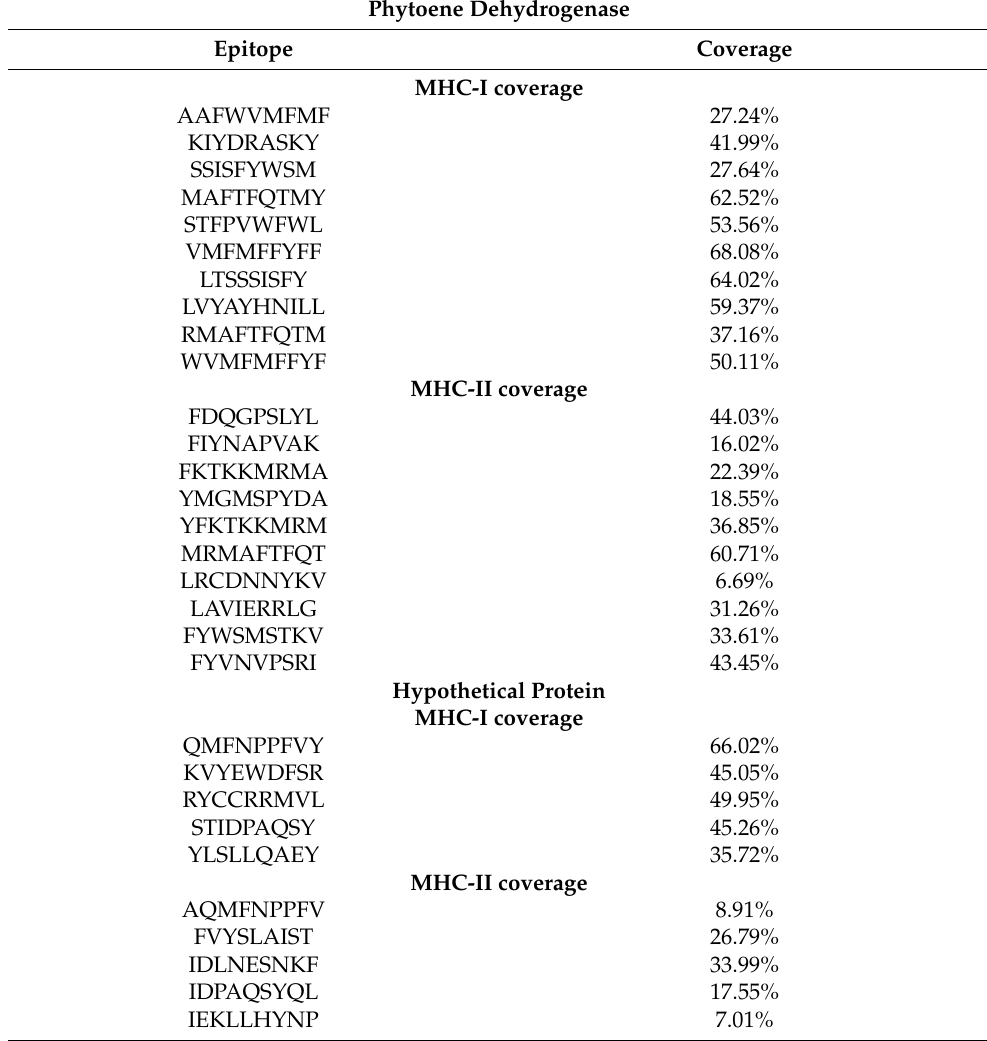
Table 3. World population coverage of MHC-I and MHC-II epitopes of the selected